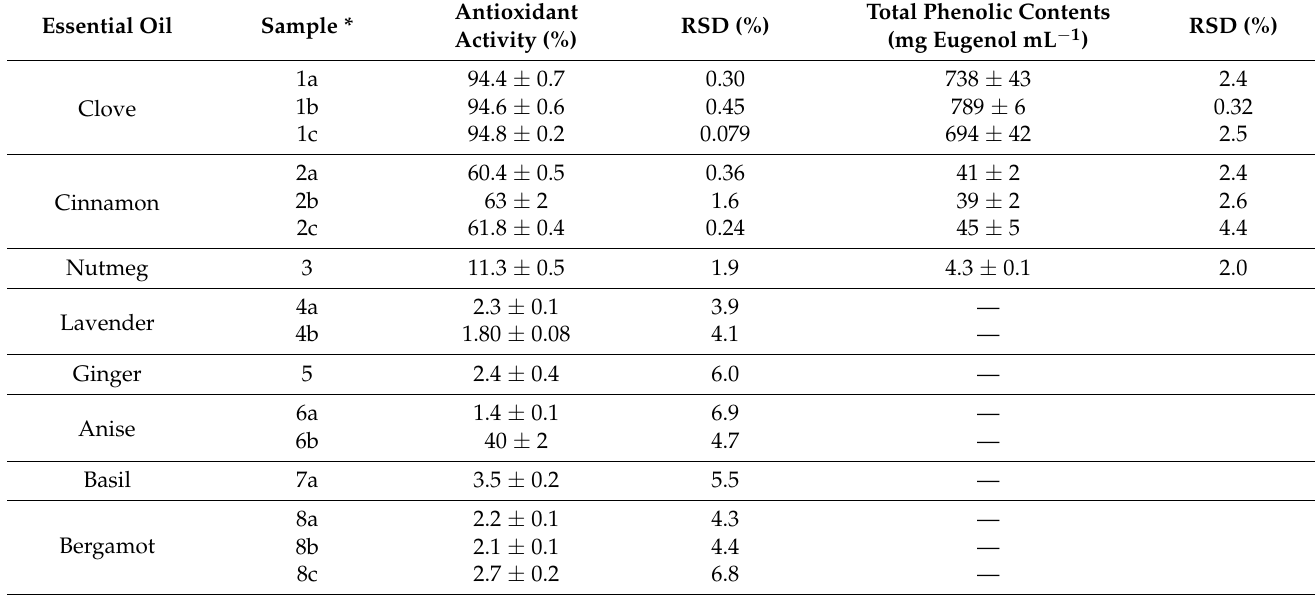
Table 4. Standard antioxidant parameters of essential oils based on spectrophotometry data ( n = 3; p =